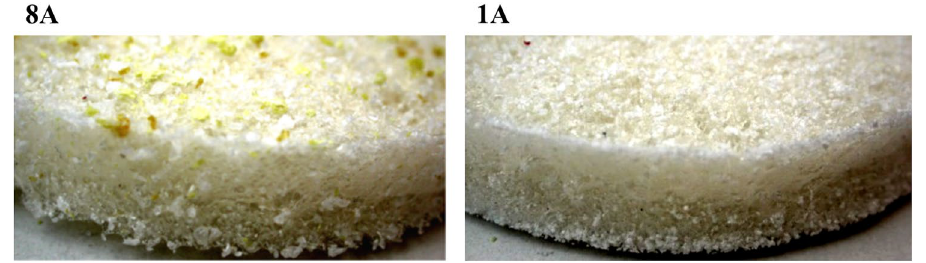
Figure 5. Pictures of upper sides of samples 8 (PS powder, left) and 1 (PET powder,